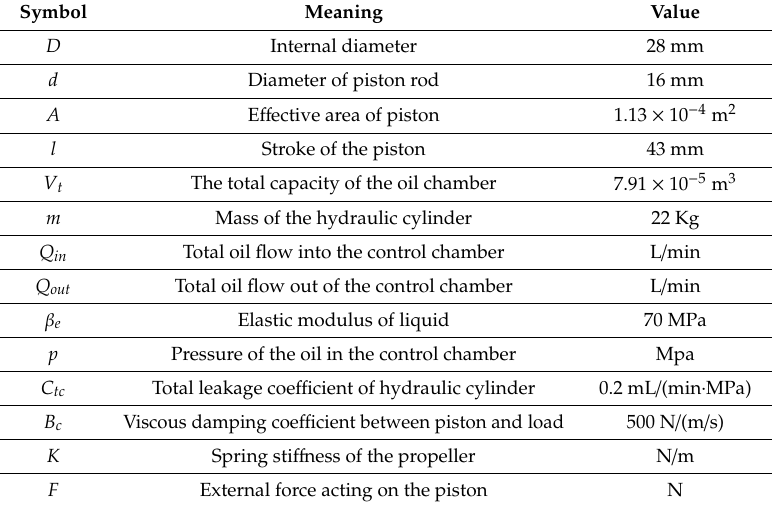
Table 1. Parameters for the hydraulic